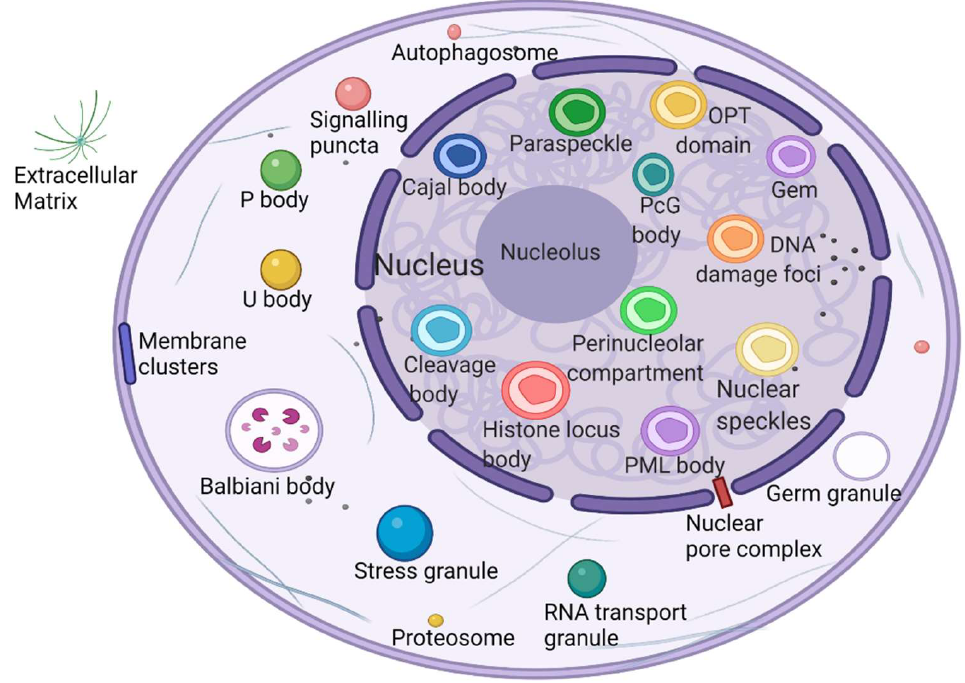
Figure 1. Biomolecular condensates located throughout the nucleus and cytoplasm. Created with BioRender.com.